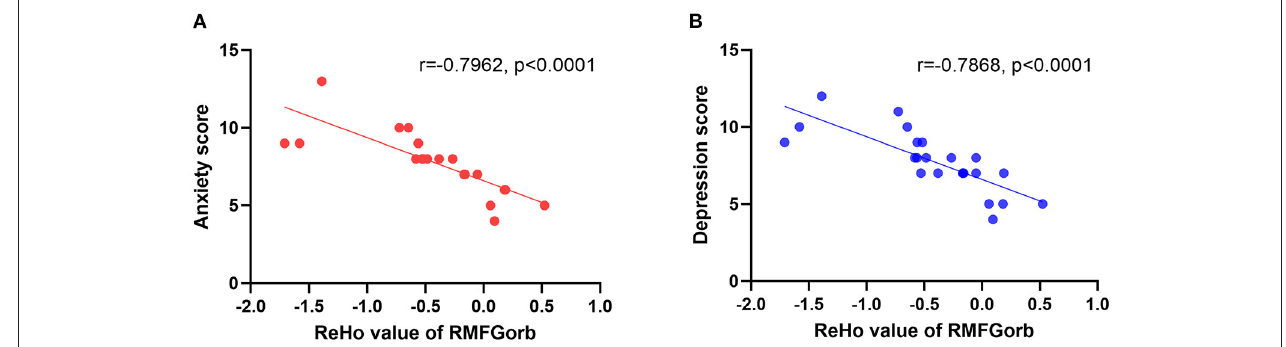
FIGURE 4 | The linear relationship between the ReHo value of the RMGForb and the anxiety score/depression score. (A) The anxiety score obtained from the HADS was negatively correlated with the ReHo value of RMFGorb, r = − 0.7962, p < 0.0001; (B) The depression score obtained from the HADS was also negatively correlated with the ReHo value of RMFGorb, r = − 0.7868, p < 0.0001. ReHo, regional homogeneity; RMFGorb, right orbit part of middle frontal gyrus; HADS, Hospital Anxiety and Depression Scale.